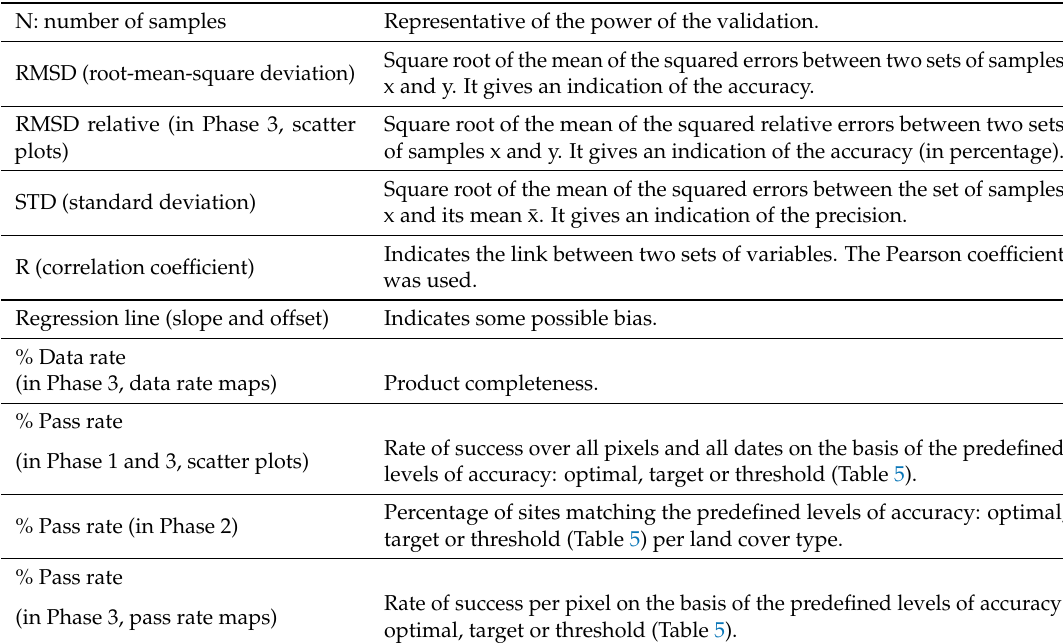
Table 7. Other uncertainty metrics used to evaluate the